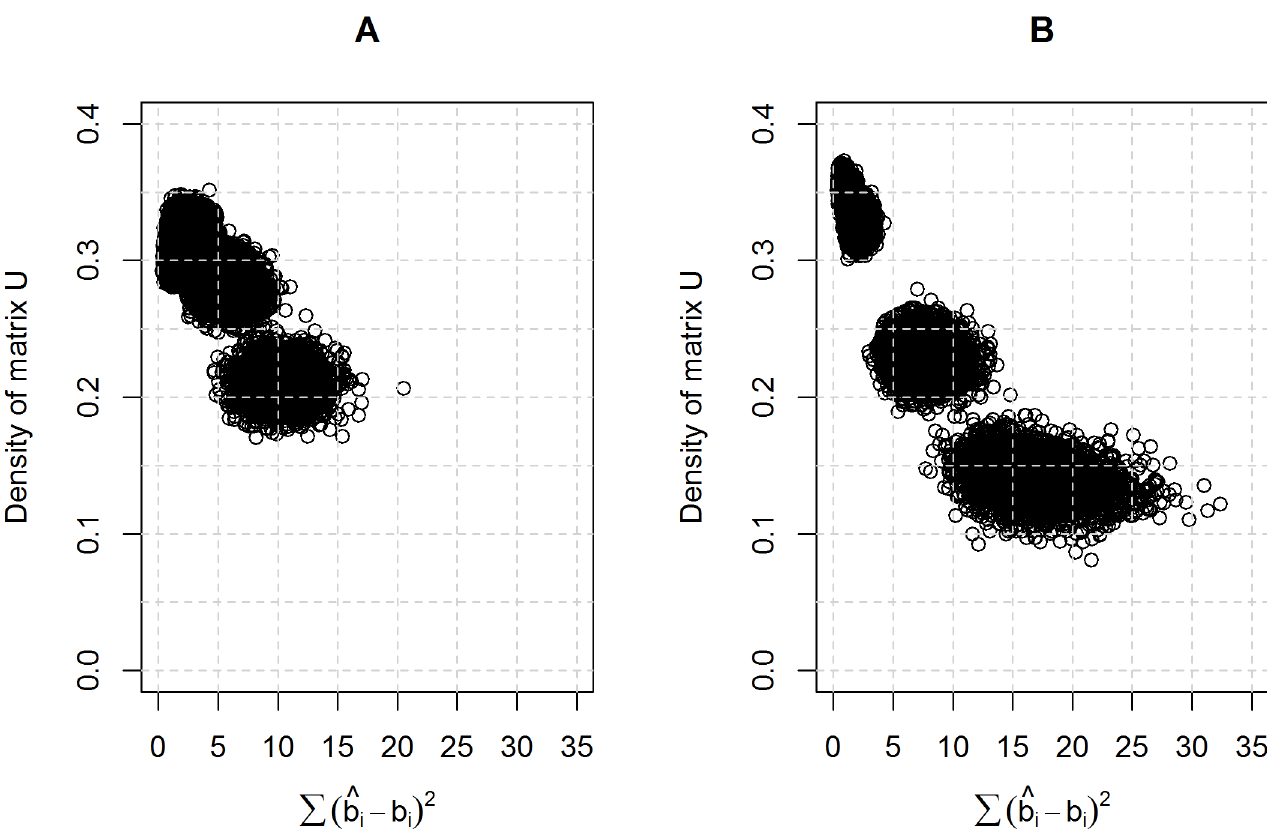
Fig 1. Residual sum of squares versus the density of matrix U. (A) Scenario 2. (B) Scenario 3.